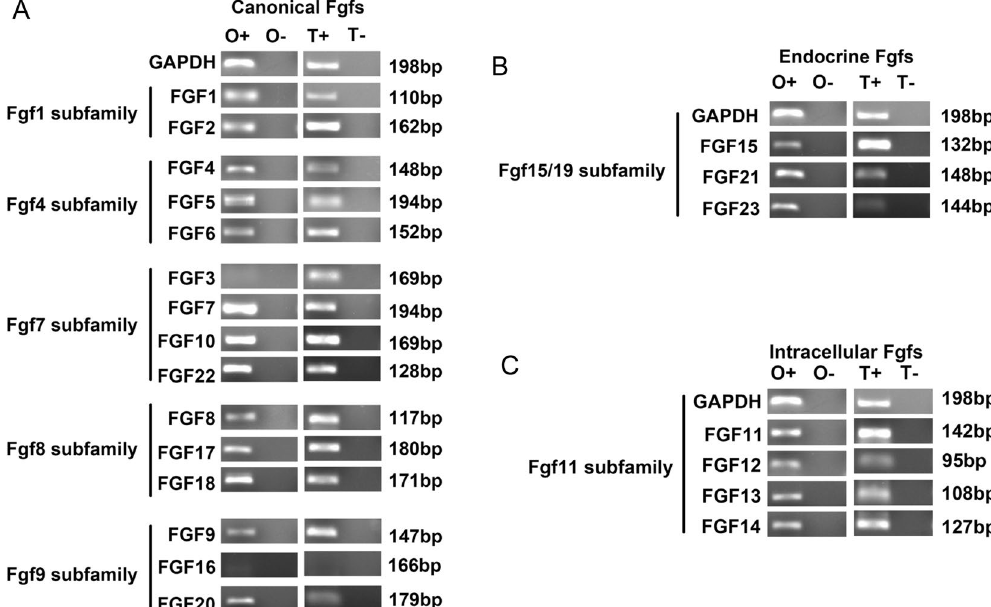
Figure 2. The relative expressions of FGF family showing the mRNA changes in osteocytes in comparison to long bone tissues. ( A ) The comparative expressions of canonical FGFs in both osteocyte cell line and bone tissue. ( B ) The comparative expressions of endocrine FGFs in both osteocyte cell line and bone tissue. ( C ) The comparative expressions of intracellular FGFs in both osteocyte cell line and bone tissue. The results shown were performed by reversed transcript PCR and revealed by relevant regions of ethidium bromide (EB) - stained agarose gels (2%). O + and T + represent reverse transcribed RNA; O − and T − represent mock reversed transcribed RNA. Size (in bp) of PCR products are indicated to the right of each panel. The data indicated were means of three independent experiments (n =